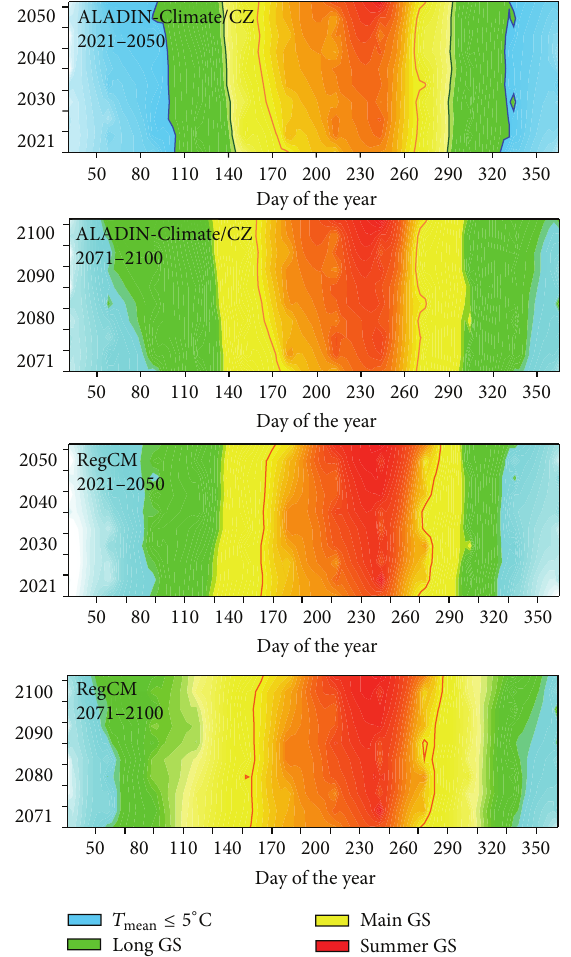
Figure 5: Hovmoller-type diagram of the spatiotemporal evolution ≥ 5 ∘ C), the main growing season of large growing season ( 𝑇 mean ≥ 10 ∘ C), and the summer growing season ( 𝑇 ≥ 15 ∘ C) ( 𝑇 mean mean projected from 116 grid points × 30 years × 365 days over the Elbe River lowland based on ALADIN-Climate/CZ and RegCM simulation data under the A1B SRES scenario runs (2021–2050 and